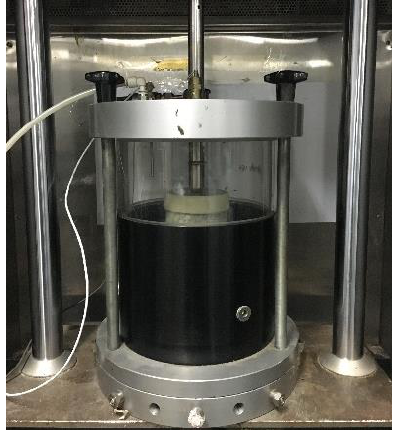
Figure 2. Process of specimen forming. ( a ) original specimen, ( b ) Core process, ( c ) Loading specimen.